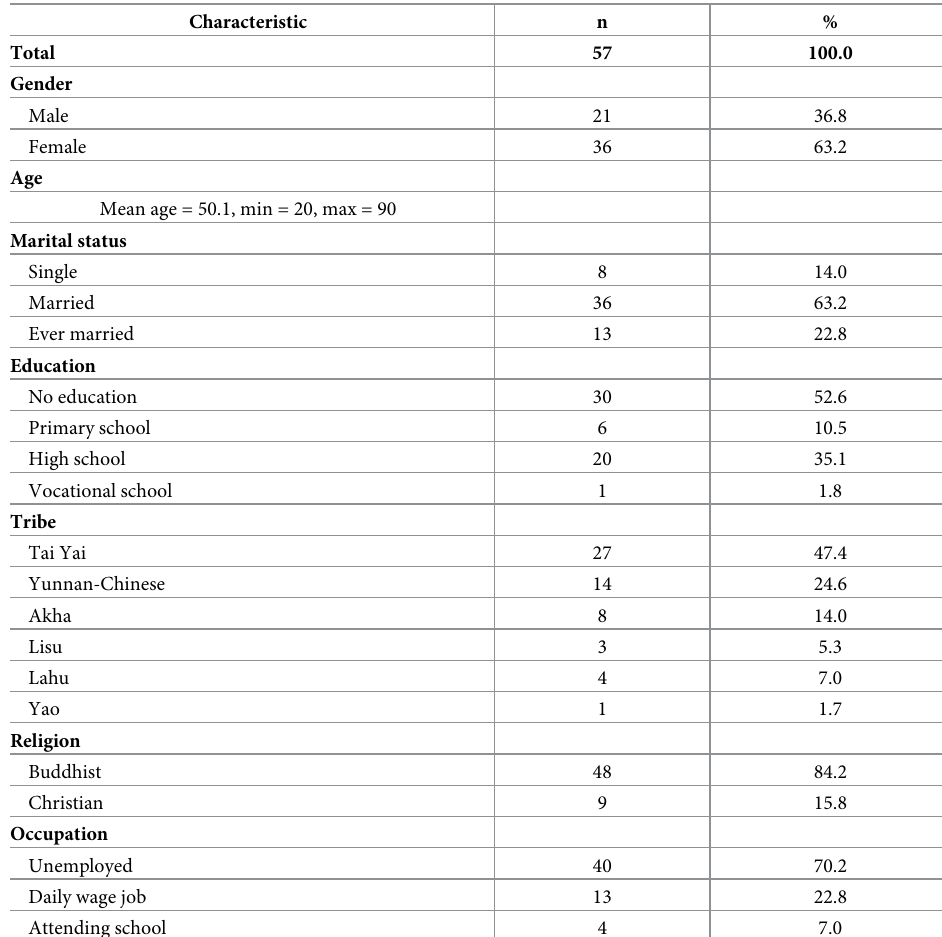
Table 1. Characteristics of